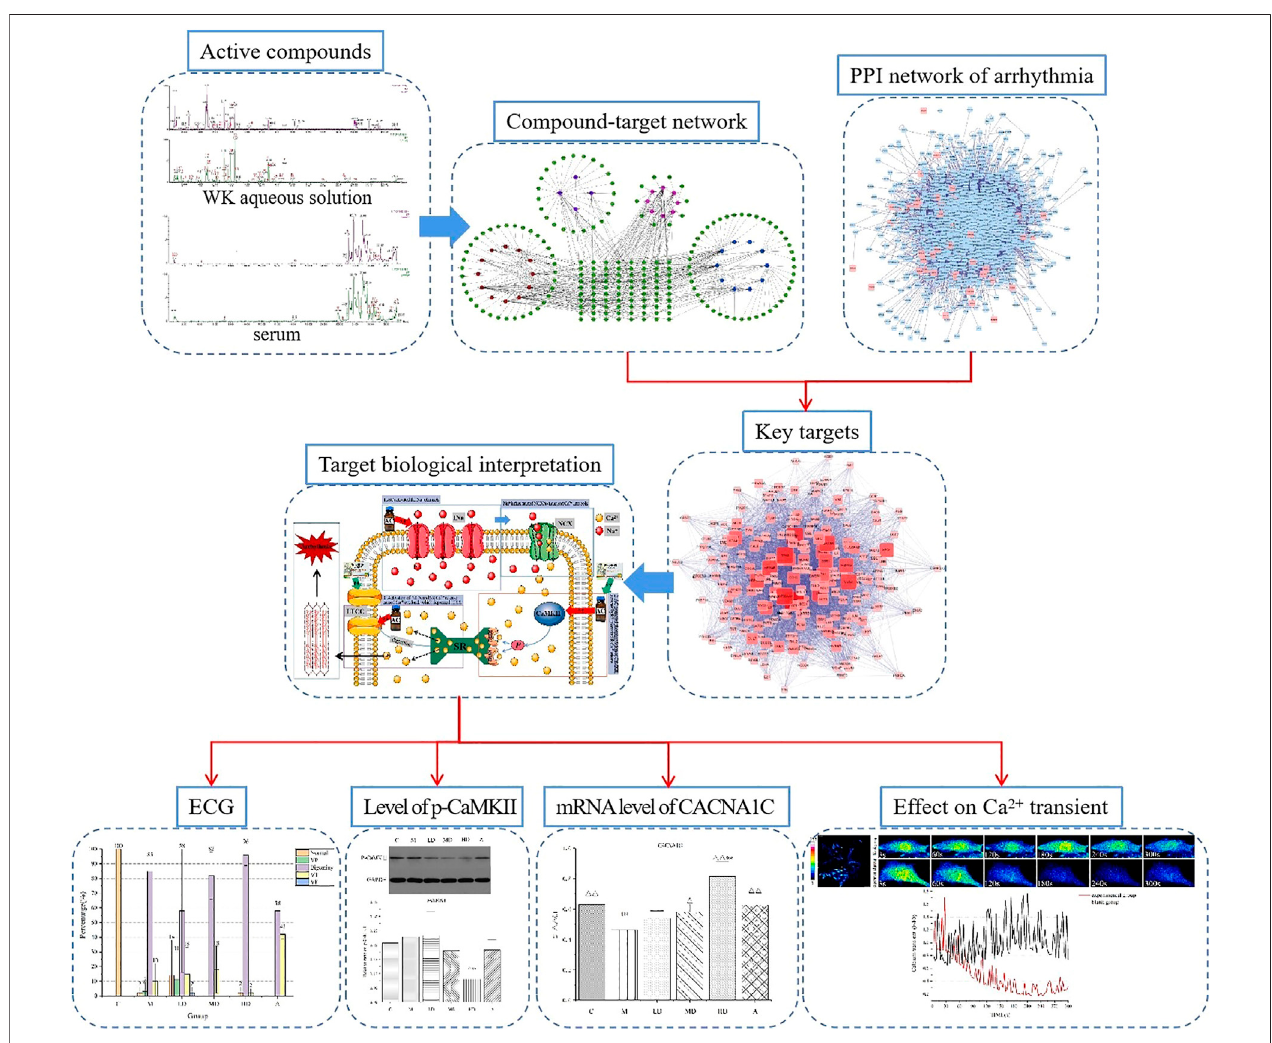
FIGURE 1 | Flowchart for the systems pharmacology approach used in this study.